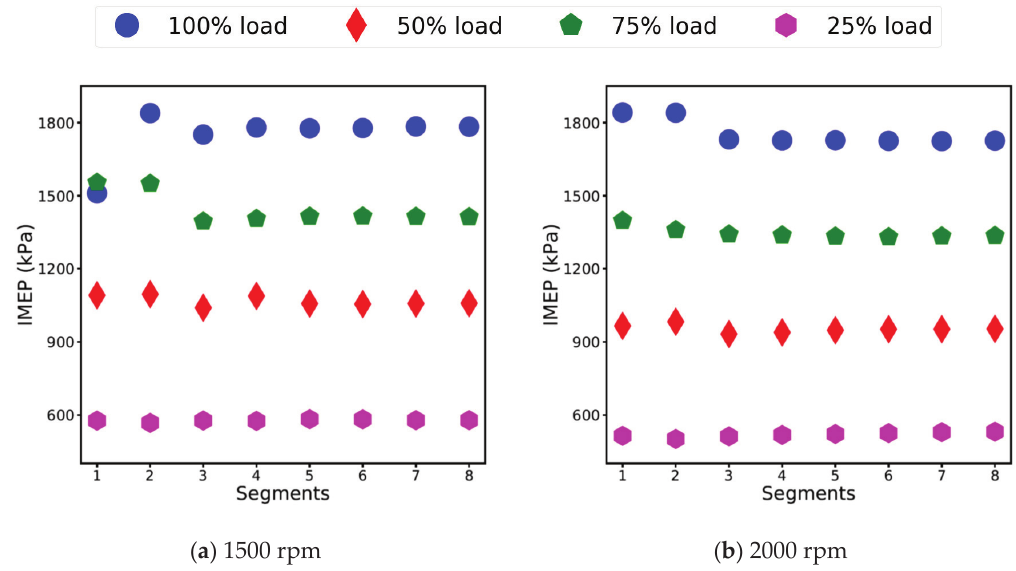
Figure 6. IMEP at each load in each segment at ( a ) 1500 and ( b ) 2000 rpm. The blue circle represents 100% load, the red diamond 50% load, the green pentagon 75% load and the pink hexagon 25% load.